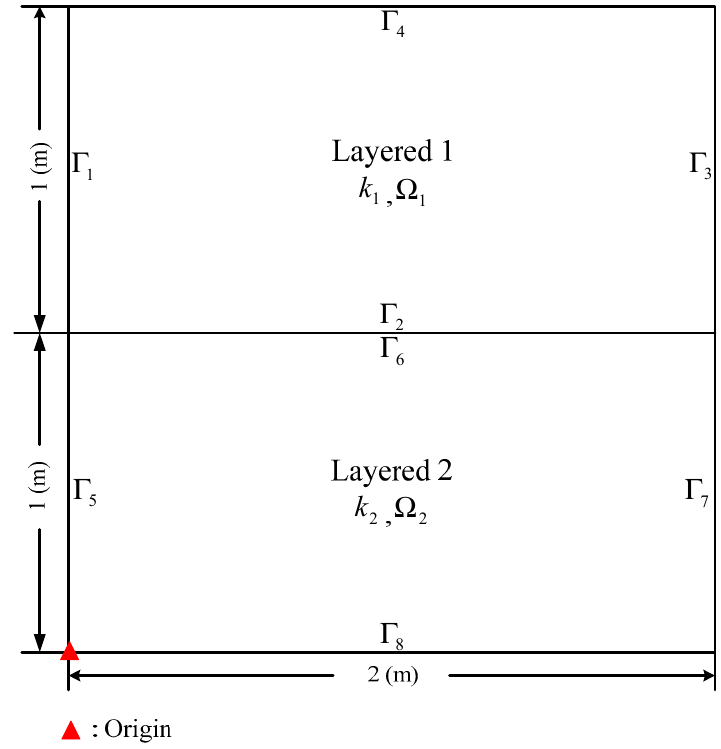
Figure 1. The profile of the composite materials for the analysis.